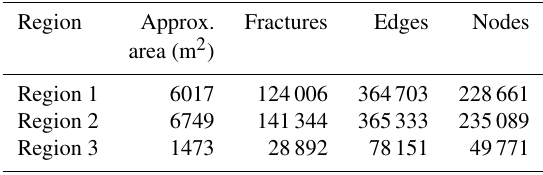
Table 1. Summary statistics for the three regions. Region Approx. Fractures Edges